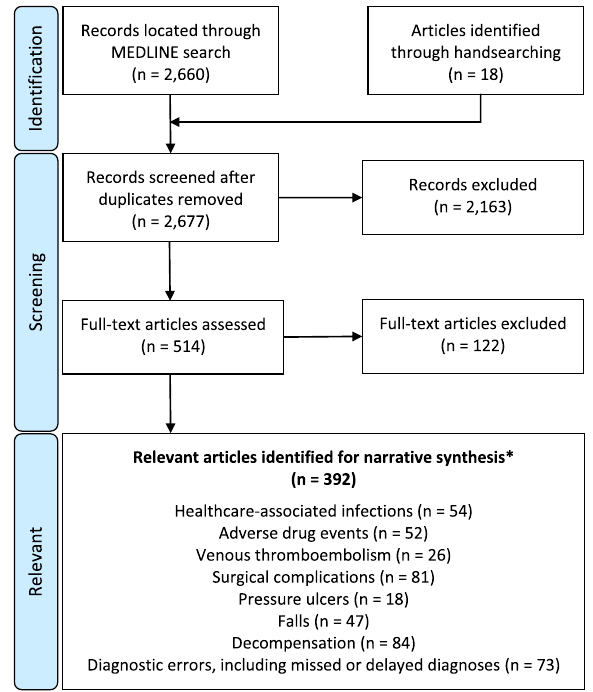
Fig. 1 PRISMA fl ow diagram showing disposition of articles. The asterisk denotes that some studies addressed multiple harm Table 1. Traditional and novel data sources that can be used to develop AI algorithms are presented in Table 2.